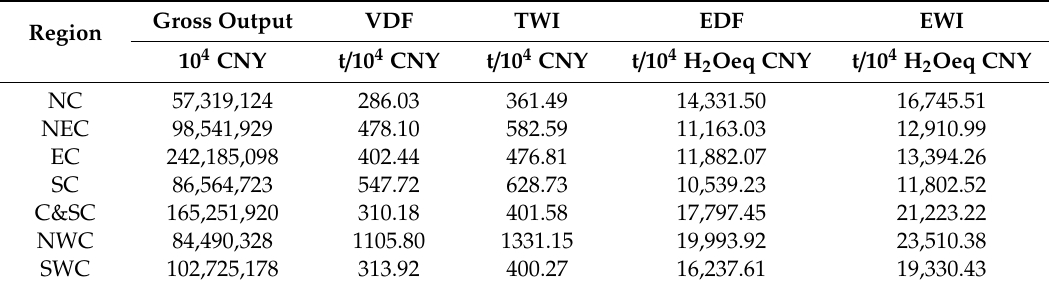
Table 2. Volumetric and impact-oriented direct water footprint intensity and total water footprint intensity for China in